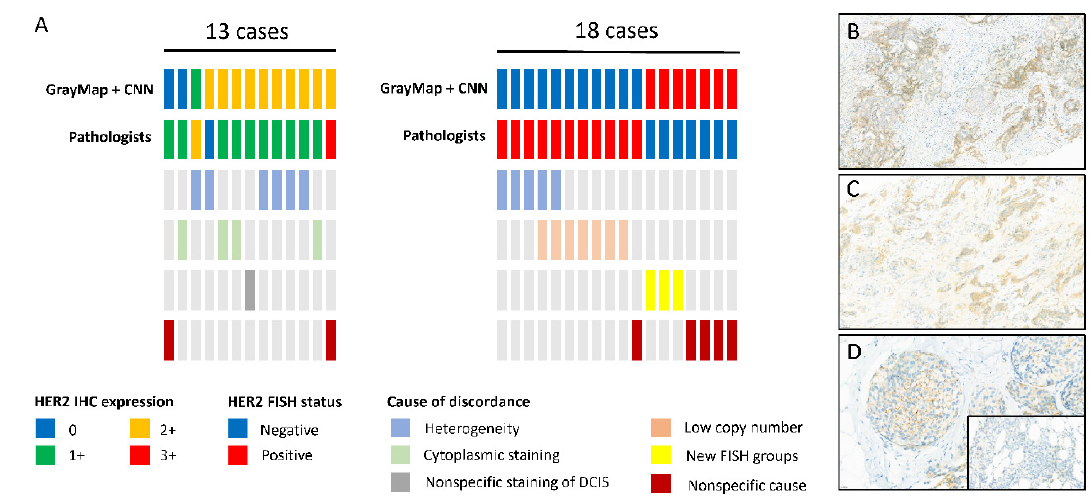
Figure 6. HER2 scoring discordance between pathologists and AI system and the possible causes of the variability. ( A ) Top 2 lines: Comparison between GrayMap model and the pathologist assessment; Bottom 4 lines: The possible causes of the variability; Left: The discordant cases on HER2 IHC classification; Right: The discordant cases on HER2 FISH classification. Vertical bars represent single cases and the representation of different colors are listed at the bottom. The typical image of ( B ) HER2 staining heterogeneity, ( C ) nonspecific cytoplasmic staining, ( D ) nonspecific staining in ductal carcinoma in situ (DCIS) with negative staining of the invasive component.